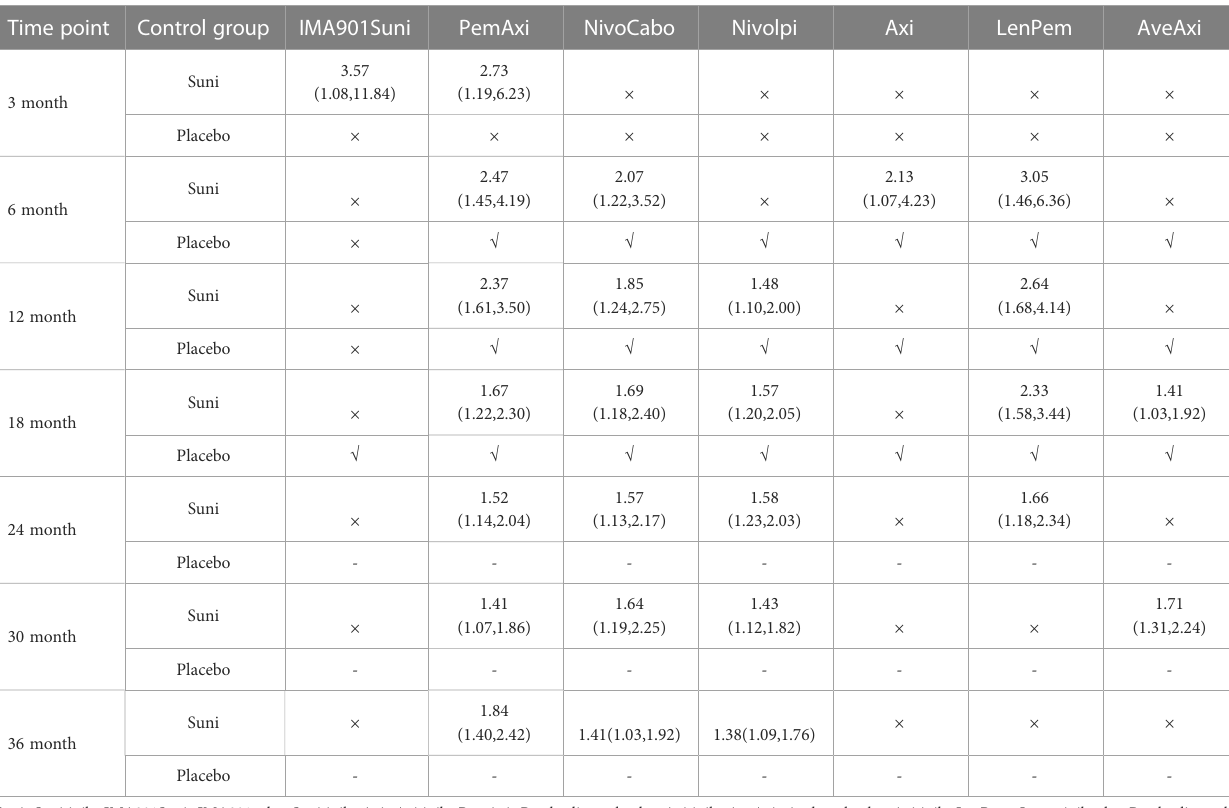
TABLE 3 Overall survival for each time point for interventions that were signi fi cant compared to Sunitinib (shown as odds ratio and 95% con fi dence intervals). Time